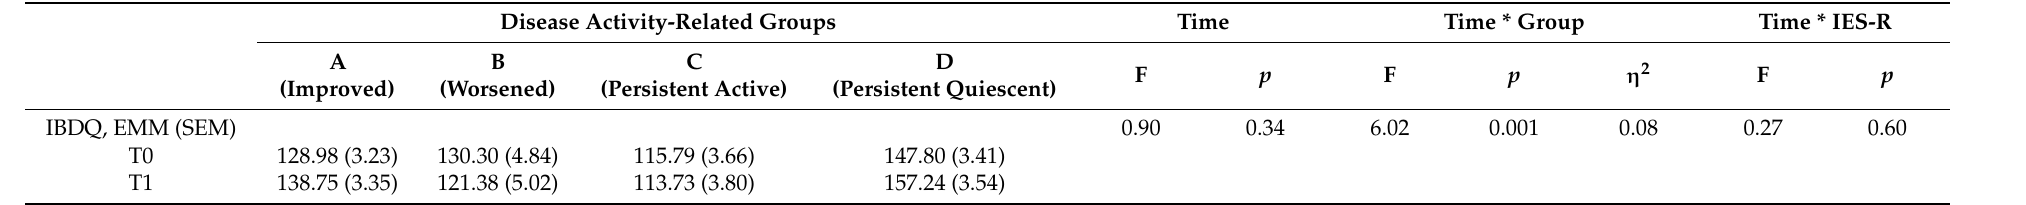
Table 4. Comparisons of HRQoL at T0 and T1 in disease activity change-related